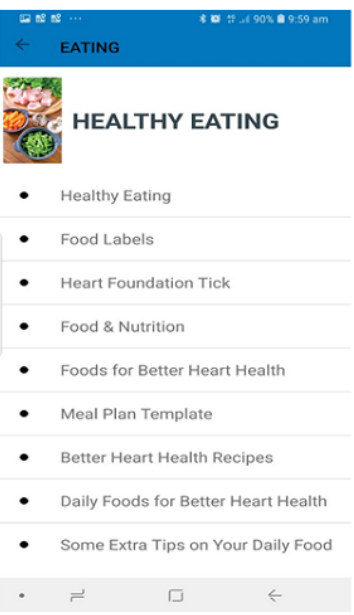
Figure 5. Educational materials.